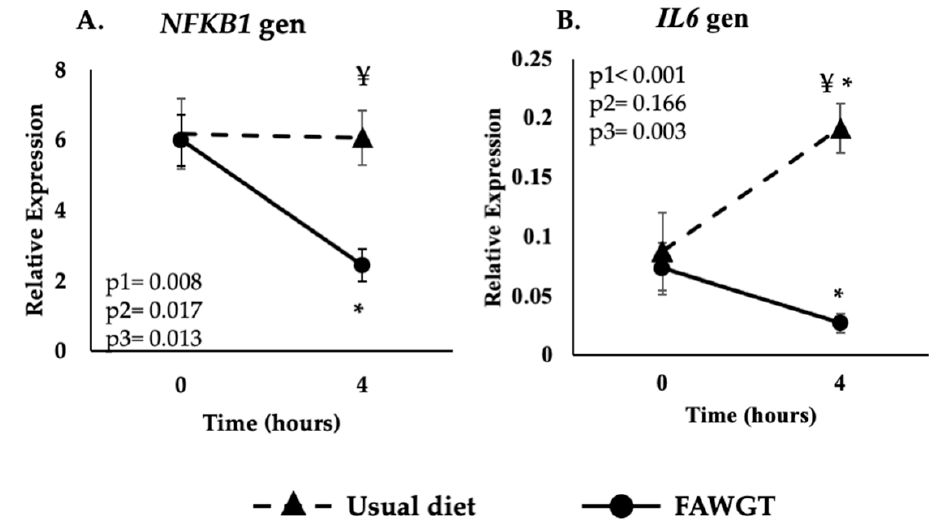
Figure 2. Postprandial expression of the inflammatory-related NFKB1 ( A ) and IL6 ( B ) genes after 8 weeks of dietary intervention with a usual diet and the diet consisting of fruit, avocado, whole grains, and trout predominant in the Colombia coffee region (FAWGT). Values are shown as mean ± S.E.M of the relative expression. The analyses correspond to ANOVA for repeated measures where p1: diet influence; p2: time, the kinetics of the postprandial response; and p3: diet–time interaction (diet vs. time). For multiple comparisons, we used the Sidak test. * p < 0.05 4 h vs. fasting state, ¥ p < 0.05 between diets at the same time.